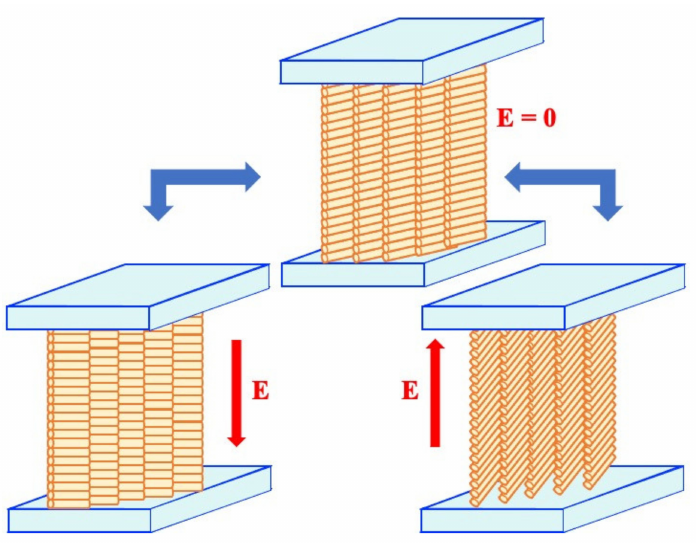
Figure 15. The expected initial molecular stacking configuration. The smectic liquid crystal molecules stacked uniformly between the two